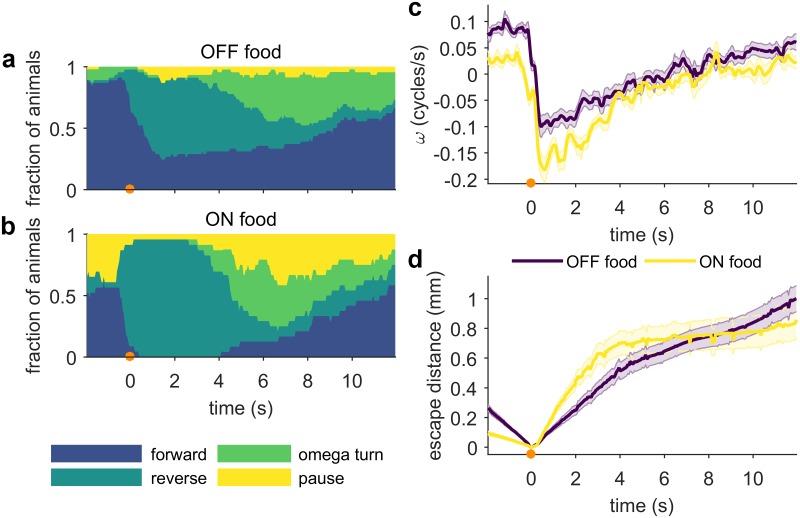
Escape reversals from noxious heat are less likely off food.Stimulus (100 ms 75 mA, focused by 75 mm lens) is at t = 0 s (indicated by an orange circle). (a-b) Fraction of animals in each behavioral state, OFF (n ≥ 46) and ON (n ≥ 24) food. Control ON food worms are washed with the same protocol as the OFF food animals. (c) Mean phase velocity. Shaded regions indicate the standard error of the mean. (d) Mean escape distance. Shaded regions indicate the standard error of the mean. Full ethograms shown in S3 Fig.